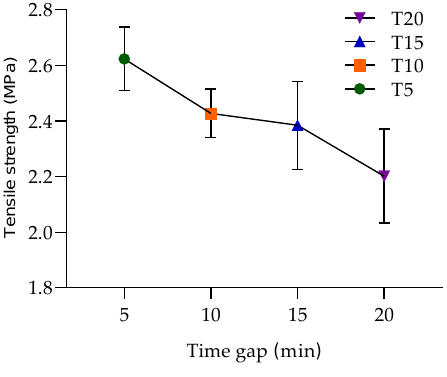
Figure 8. Interface failure trend of the specimens with different time depositions of the bottom layer, which are given in more detail in the descriptive statistics (Table 4) .